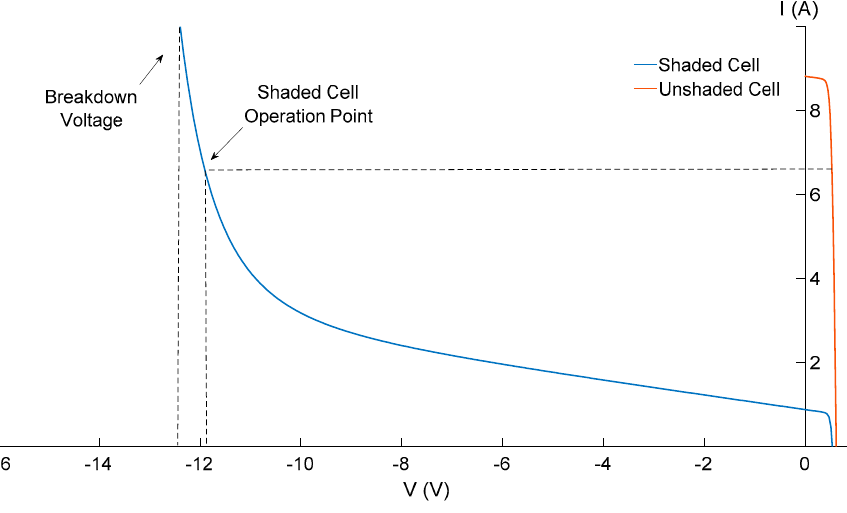
Figure 2. I-V curve of a PV module in a reverse bias region.